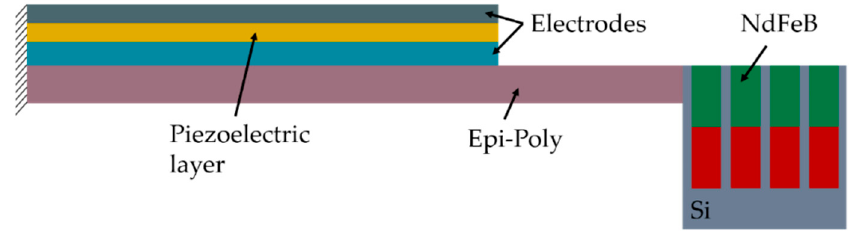
Figure 2. Simplified cross-section of the MEMS piezoelectric vibrational energy harvester with integrated NdFeB micromagnets (refer to Section 3 for more details). integrated NdFeB micromagnets (refer to Section 3 for more